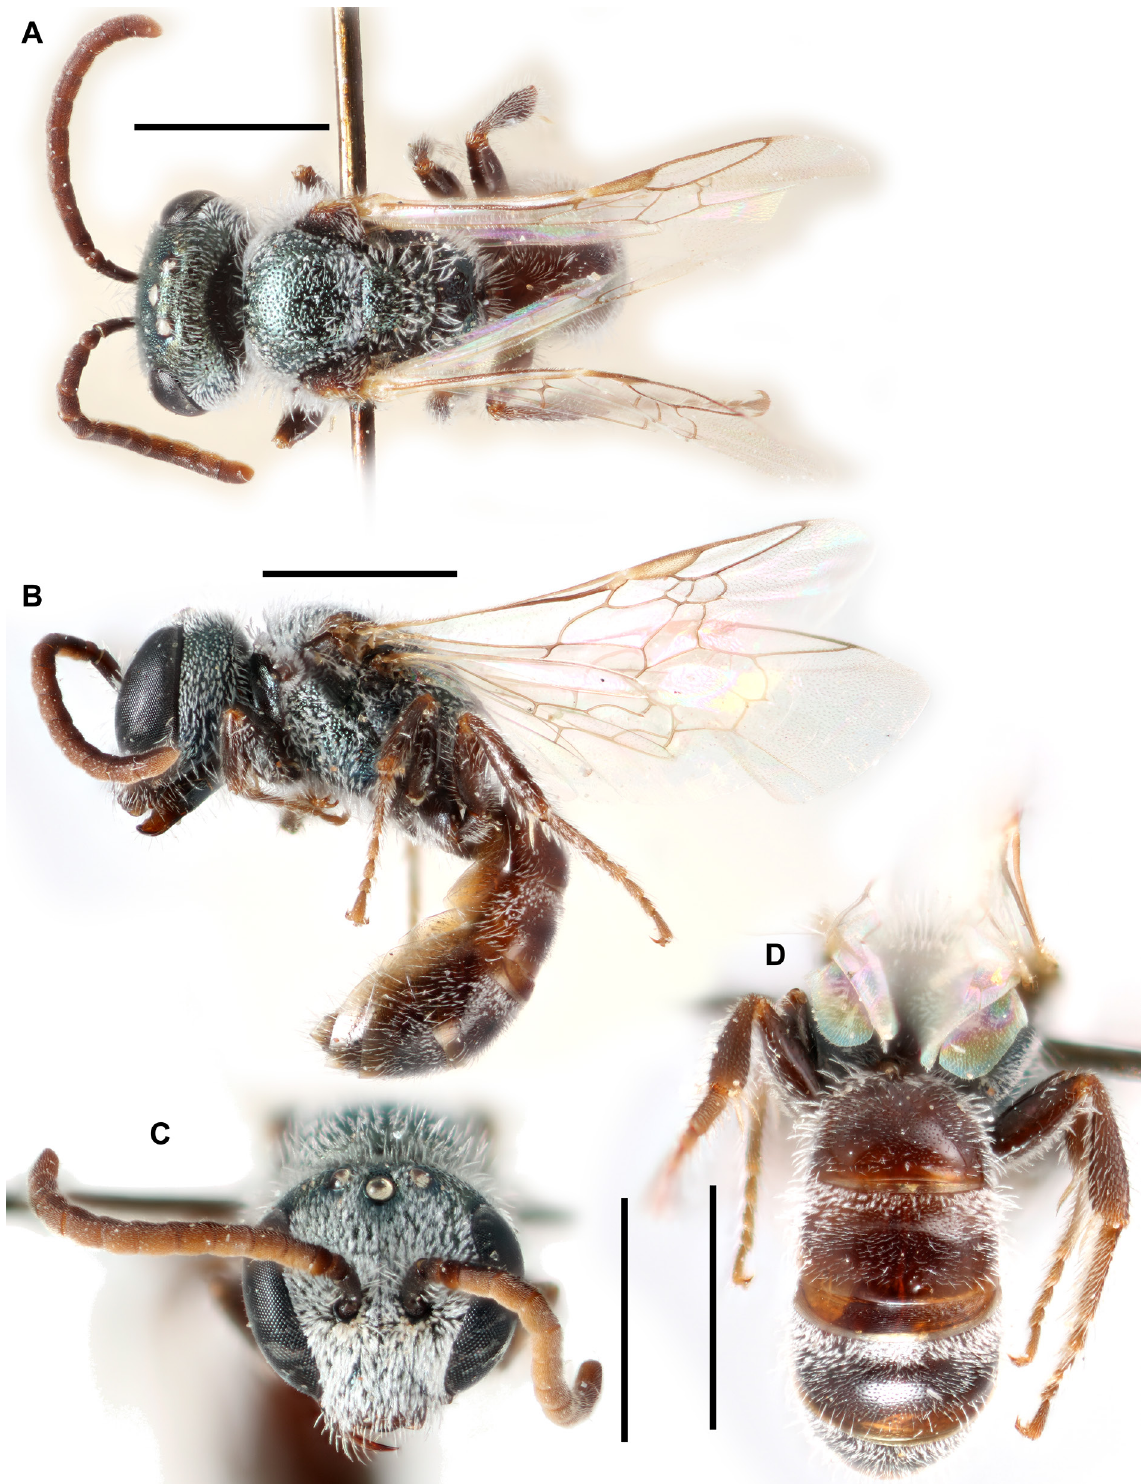
Fig. 28. Lasioglossum ( D .) gloriosum sp. nov., ♂, from Utah, Bluff (CUIC). A . Dorsal habitus. B . Lateral habitus. C . Face. D . Metasoma. Scale bars = 1